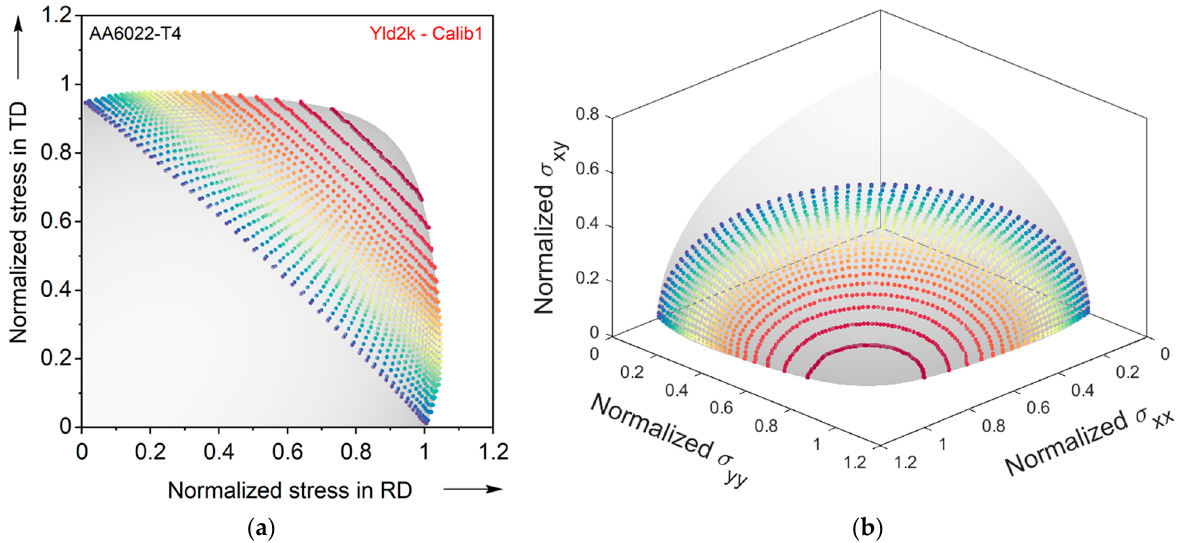
Figure 10. Predicted stress states for Calib1. ( a ) First quadrant of the plane-stress yield locus in the plane with σ xy = 0, and ( b ) fully-3D view. The colors correspond to the locations identified in Figure 9.